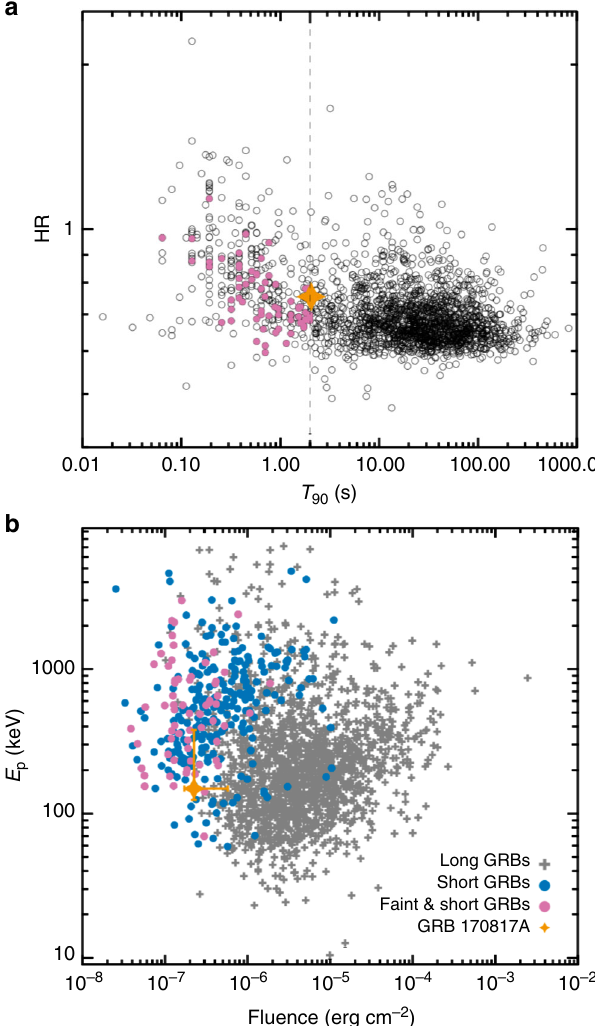
Fig. 2 Comparisons between GRB 170817A and other GRBs. a A comparison between GRB 170817A and other Fermi long and short GRBs in the T 90 − HR diagram. The hardness ratio (HR) is de fi ned as ratio of the observed counts in the 50 – 100 keV band compared to the counts in the 25 – 50 keV band within the T 90 region. b GRB 170817A in the fl uence vs. E p diagram against other